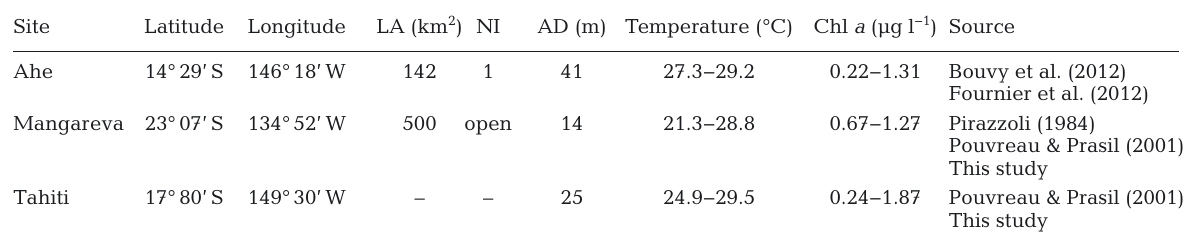
Table 1. Characteristics of the 3 studied lagoons. AD = average depth; LA = lagoon area; NI = number of inlets to the ocean. –: not applicable because it is a reef